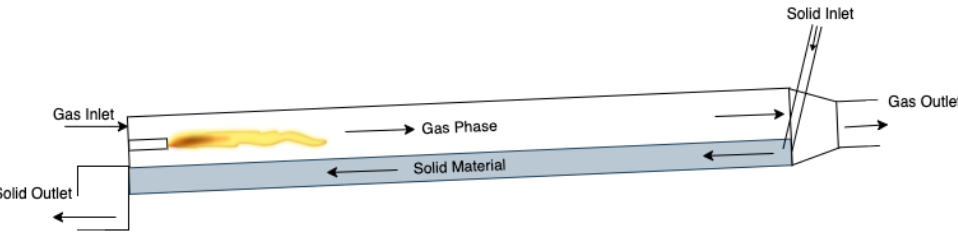
Figure 1. Rotary kiln with counter flow of the gas and